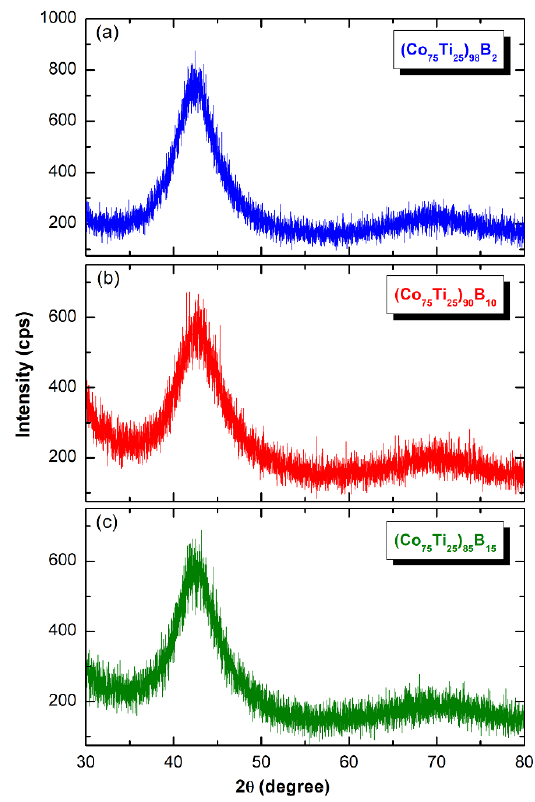
Figure 4. X-ray diffraction (XRD) patterns of MA ( a ) (Co 75 Ti 25 ) 98 B 2 , ( b ) (Co 75 Ti 25 ) 90 B 10 , and ( c ) (Co 75 Ti 25 ) 85 B 15 powders, obtained after 50 h of BM.